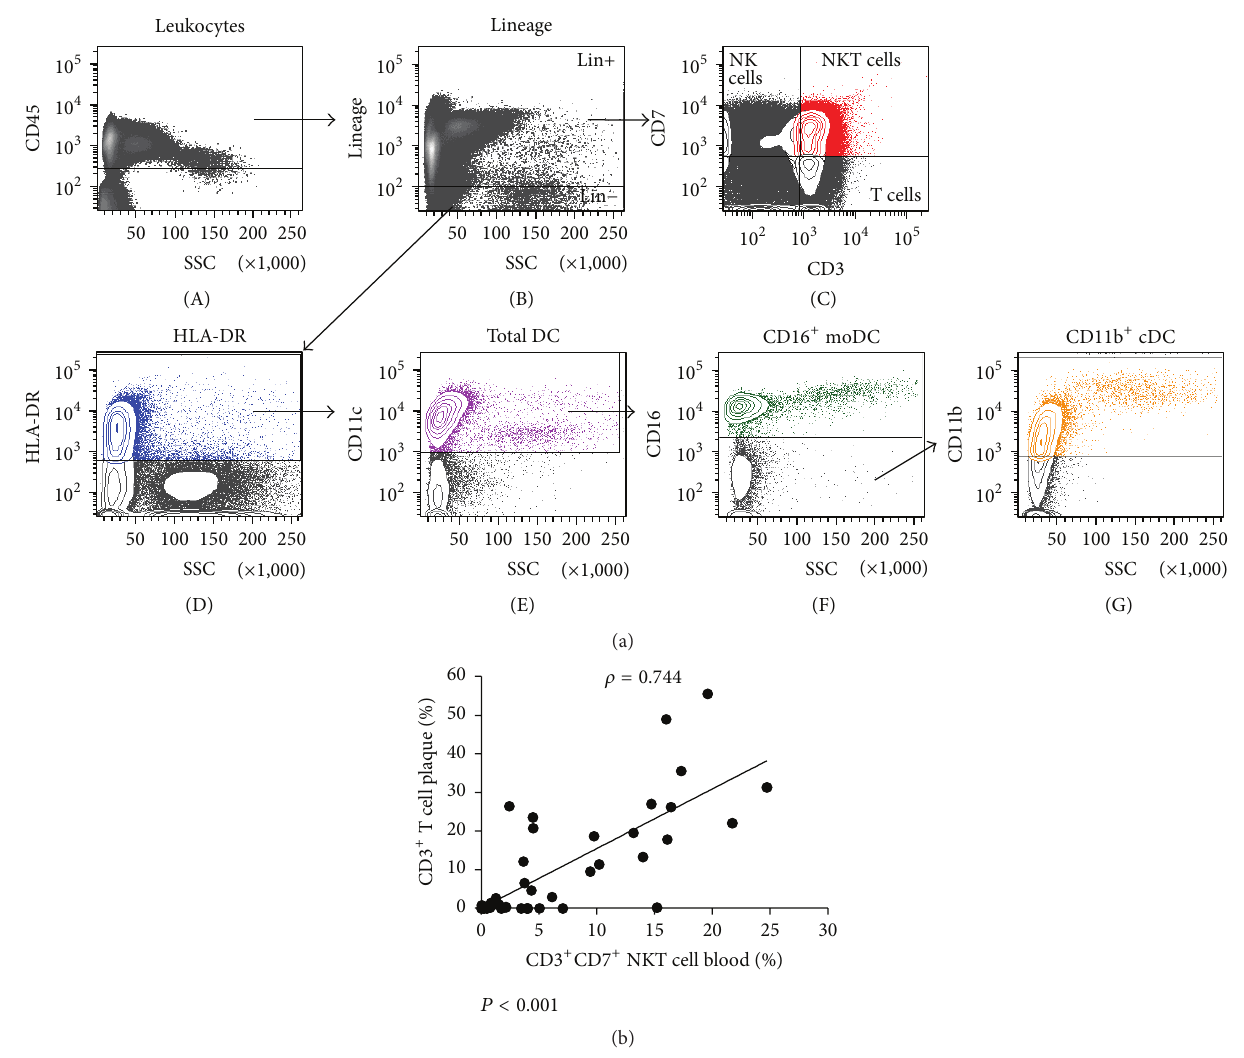
Figure 5: Leukocyte subsets and correlation analysis in human plaques and blood. (a) Gating strategy for the analysis of leukocyte(s) (subsets) in human plaque and blood samples. After staining the leukocyte population using a CD45 pan leukocyte antibody (A), lineage markers (= a CD3, CD14, CD19, CD20, and CD56 cocktail) were used to separate the DC (lineage − ) from the other immune cells (lineage+) (B). Within the lineage+ cells we identified T cells, NK cells, and NKT cells, which were defined as CD3 + , CD3 − CD7 + , and CD3 + CD7 + , respectively (C). cDC were then identified as positive for HLA-DR (D) and CD11c (E). CD16 was used for the staining of monocyte-derived DC (F). Subsequently, CD11b + cDC (G) were gated from the CD16-negative population. Within the lineage+ population we identified monocytes in blood as HLA-DR + CD11c + CD11b + CD14 + and macrophages in plaques as HLA-DR + CD11c + CD11b + CD68 + (plots not shown). (b) Spearman’s rank correlation plot showing the relationship between CD3 + CD7 + NKT cell numbers in blood and the percentage of total CD3 + T cells in plaques obtained from the same endarterectomy patient ( 𝑛 = 57